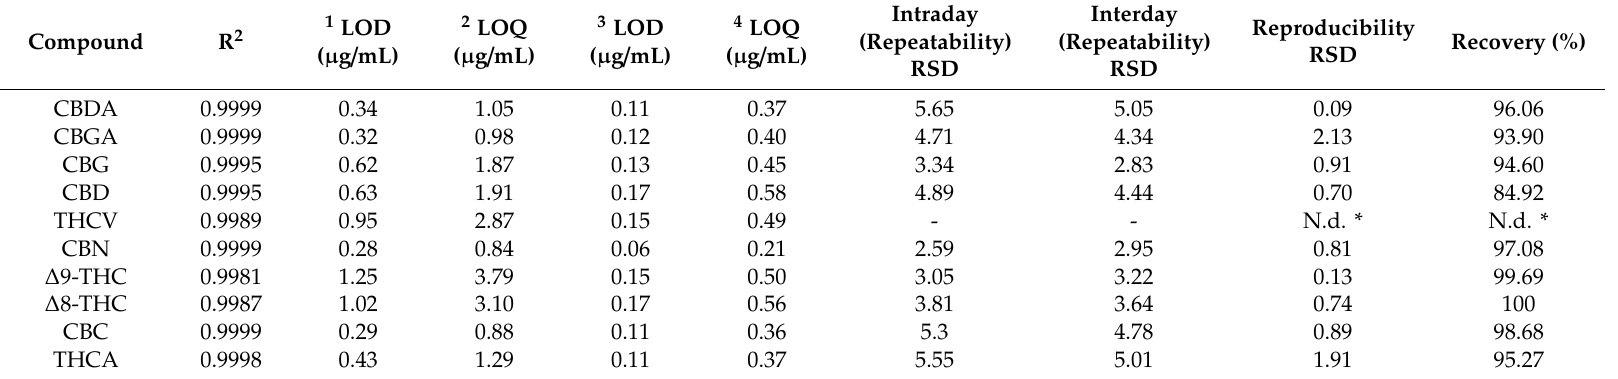
Table 1. Validation parameters of RP-HPLC-UV